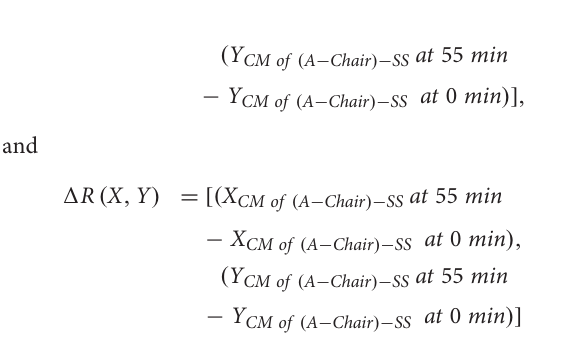
FIGURE 3 | Single differential RMS maps relative to subject 15 for chair SS (left side panels) and A-chair (right side panels) at the beginning (0 min) and the end (55 min) of the test. Maps were computed on the entire 20 s length of the signals. An image interpolation by a factor of 15 was applied (1 pixel = 0.6 mm). The region of activity (ROA) is identified by means of map segmentation (Caselles et al., 1997). Above each map the mean, minimum and maximum values of surface electromyography (sEMG) over the entire map are reported ( µ V RMS ). The centroid of each ROA, the color scale (0–30 µ V RMS ) and a schematic representation of the vertebrae (T11-L4) are indicated. The sign convention for centroid displacements is described at the bottom, a shift if X CM to the left is in the lateral direction (away from the spine), for the left map, whereas it is in the medial direction (toward the spine) for the right side